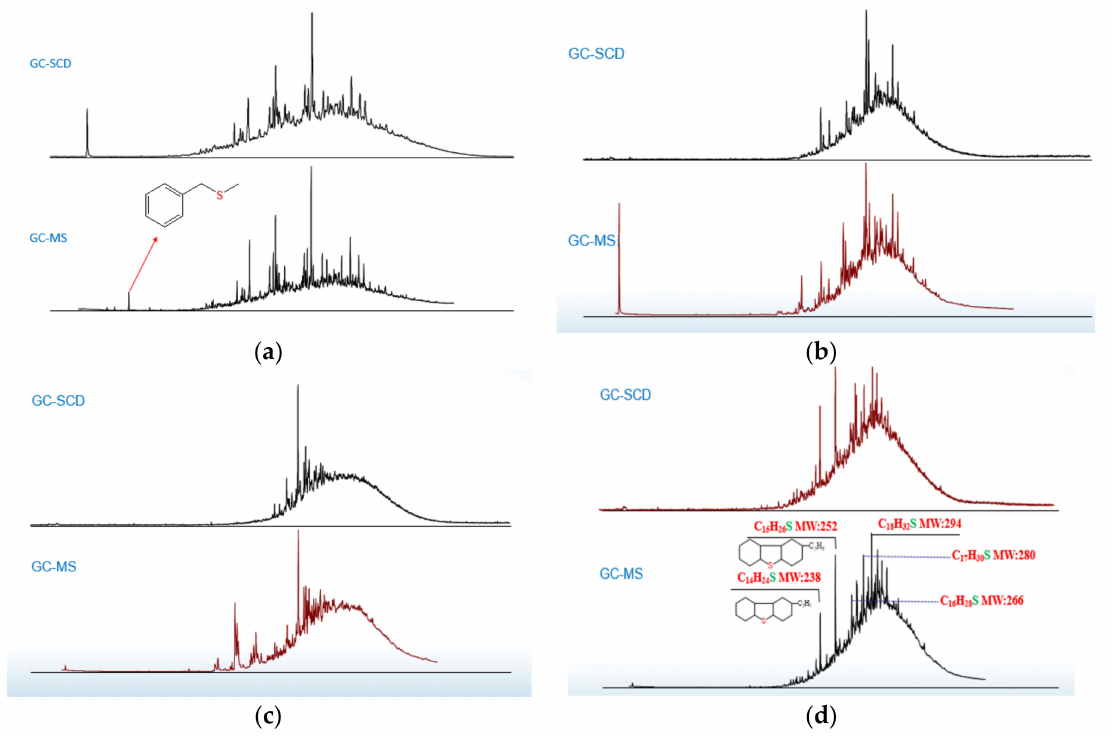
Figure 4. The GC-SCD and GC-MS spectra of thioether sulfur: ( a ) WLT, ( b ) HCT, ( c ) QZT, and ( d ) HLT. The FT-ICR MS distribution of thioether sulfur in WLT, HCT, QZT, and HLT are shown in Figure 5, from which the distribution characteristics of thioether sulfur in transformer oil can be inferred. The carbon number of thioether sulfur in transformer oil is mainly distributed between 14 and 24, and the unsaturation is mainly distributed between 2 and 8. Compounds with unsaturation of 3 and unsaturation of 6 are the most abundant.